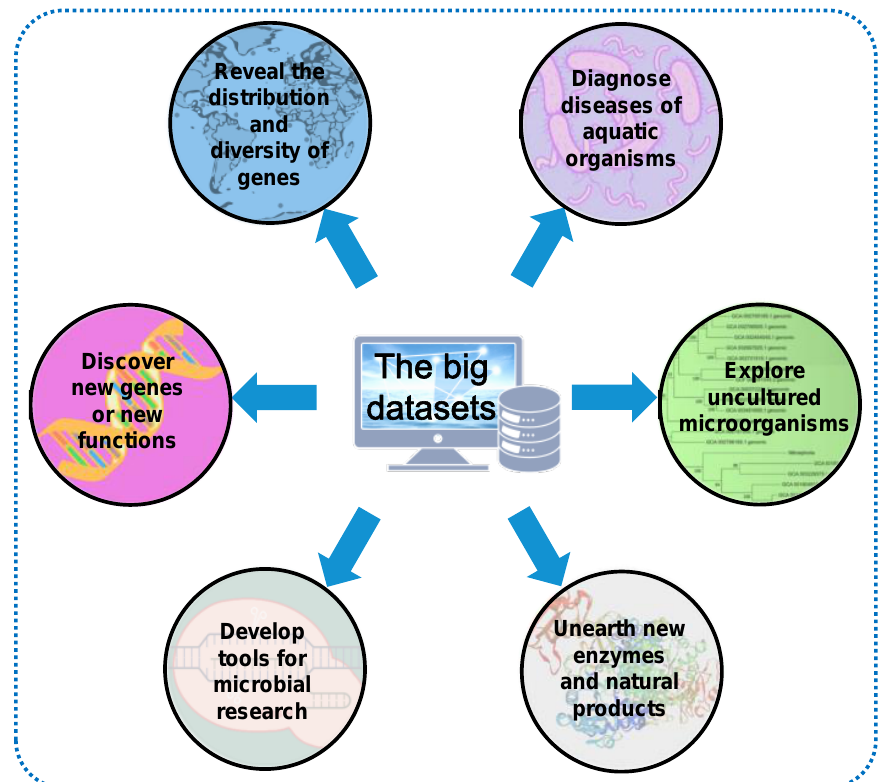
Figure 3. Transformation of the global ocean microbiome datasets.